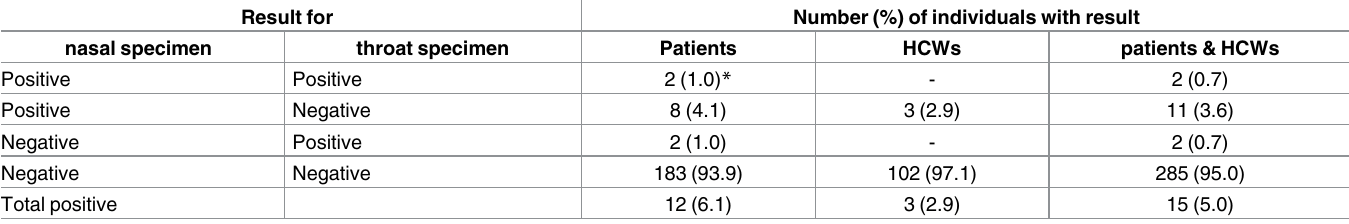
Table 2. Presenceof methicillin-resistant Staphylococcus sciuri in nasal and throat swab samplesobtained from hospitalised patients and health- care workers (HCWs). Result for